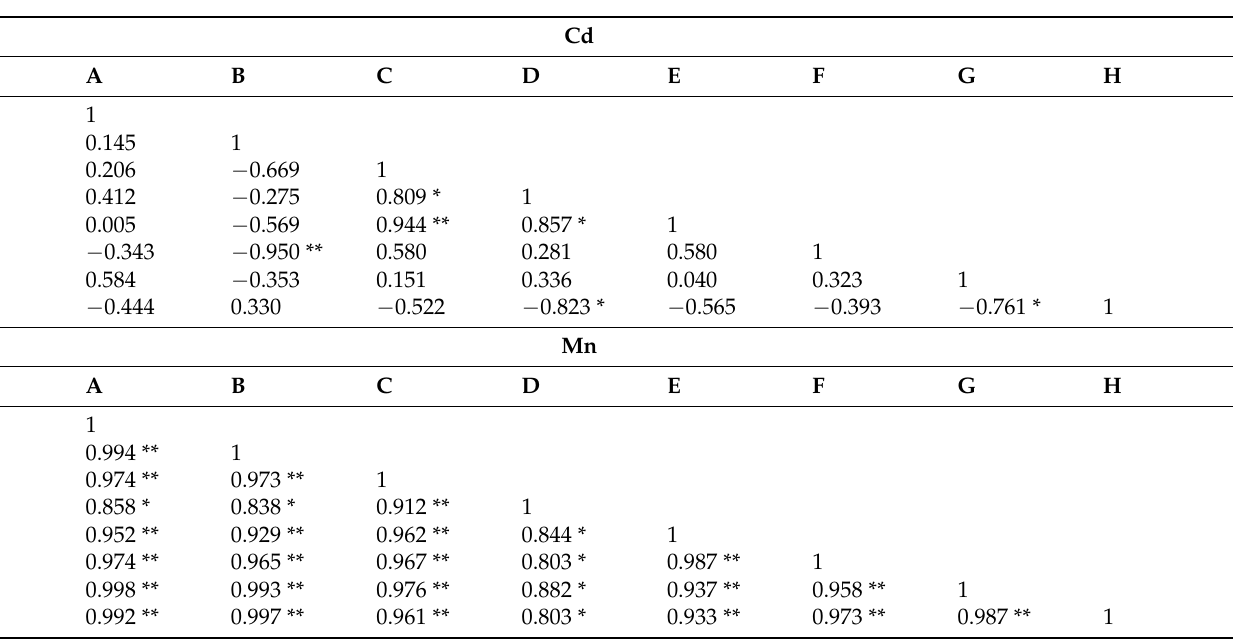
Table 5. The correlation between the digestion methods for Cd, Mn, Al and Mg determined in plant tissues (Pearson